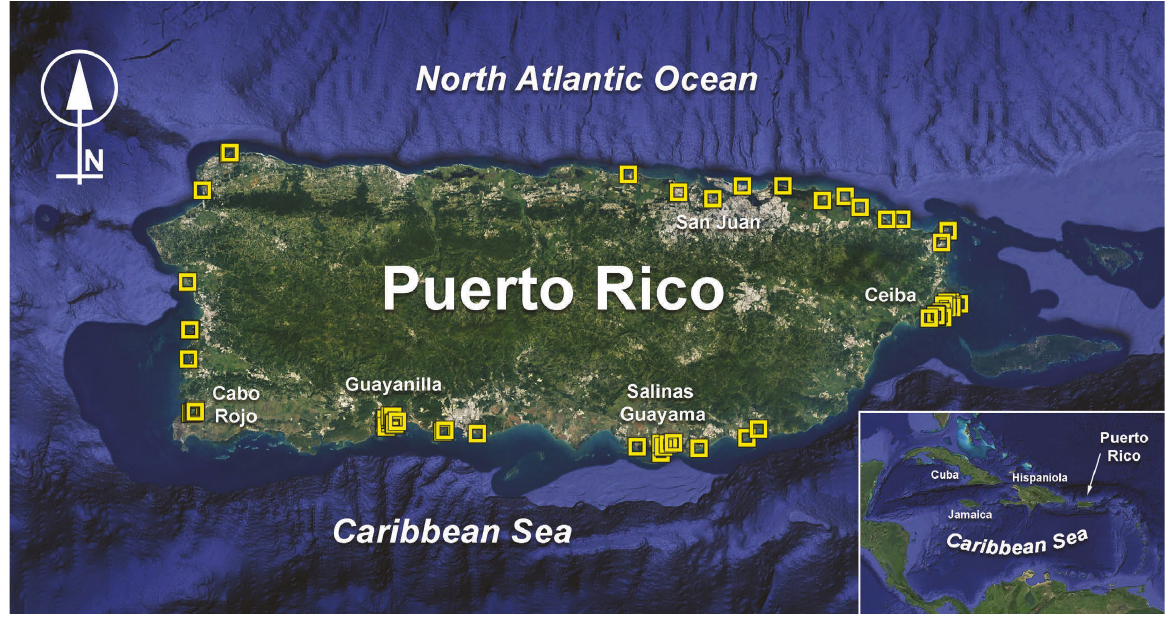
Figure 1: Capture or rescue locations for Antillean manatees included in this study.